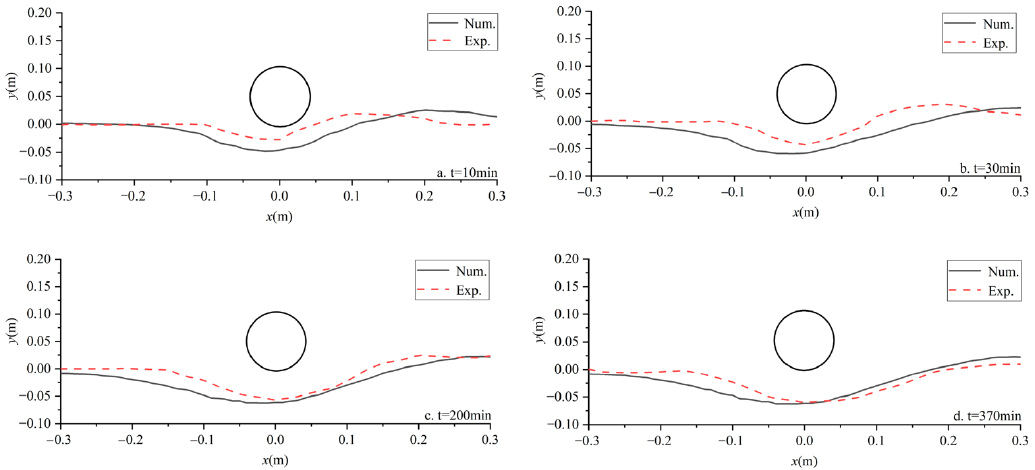
Figure 3. Pipeline equilibrium scour terrain and depth in clear water.